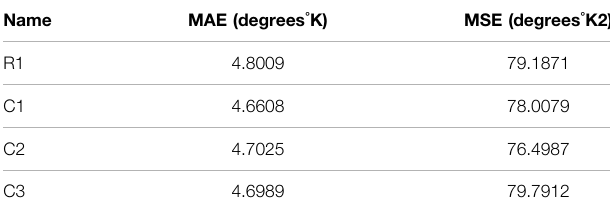
TABLE 3 | Results of training of neural networks with cross